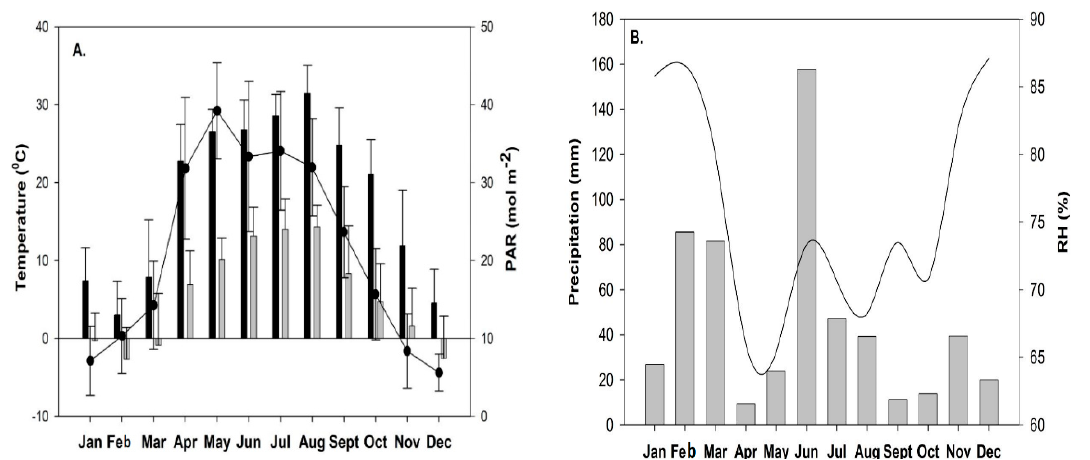
Figure 2. ( A ) Monthly average of the maximum and minimum values of air temperature (in 0 °C, Tmax, black bars and Tmin, grey bars) and the photosynthetically active radiation (PAR, in mol m − 2 ) values at Bugac site. ( B ) Monthly sum of precipitation (mm) and average relative humidity (%) during the study period in 2018 at the Bugac site.